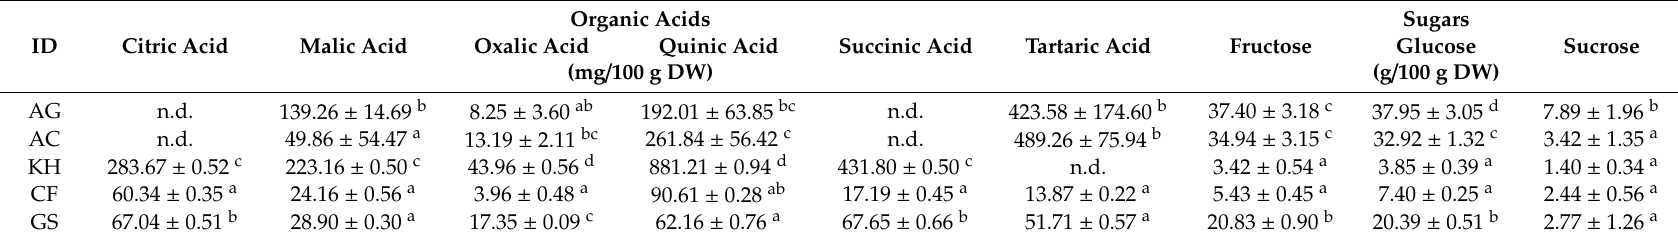
Table 5. Organic acids and sugars in analysed dried fruit